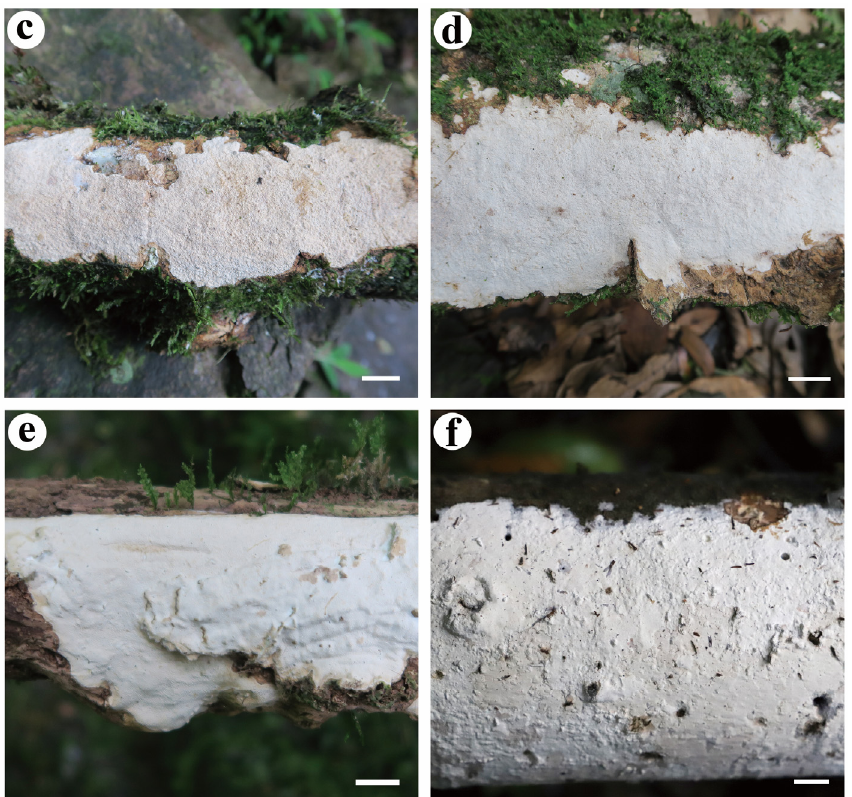
Figure 4. Basidiomes of Crustomyces isabellinus . Scale bars: ( a – f ) = 1 cm. ( a ). He 3582 (BJFC 022082); ( b ). He 4755 (BJFC 024274); ( c ). He 4852 (BJFC 024371); ( d ). He 4872 (BJFC 024391); ( e ). He 4884 (BJFC